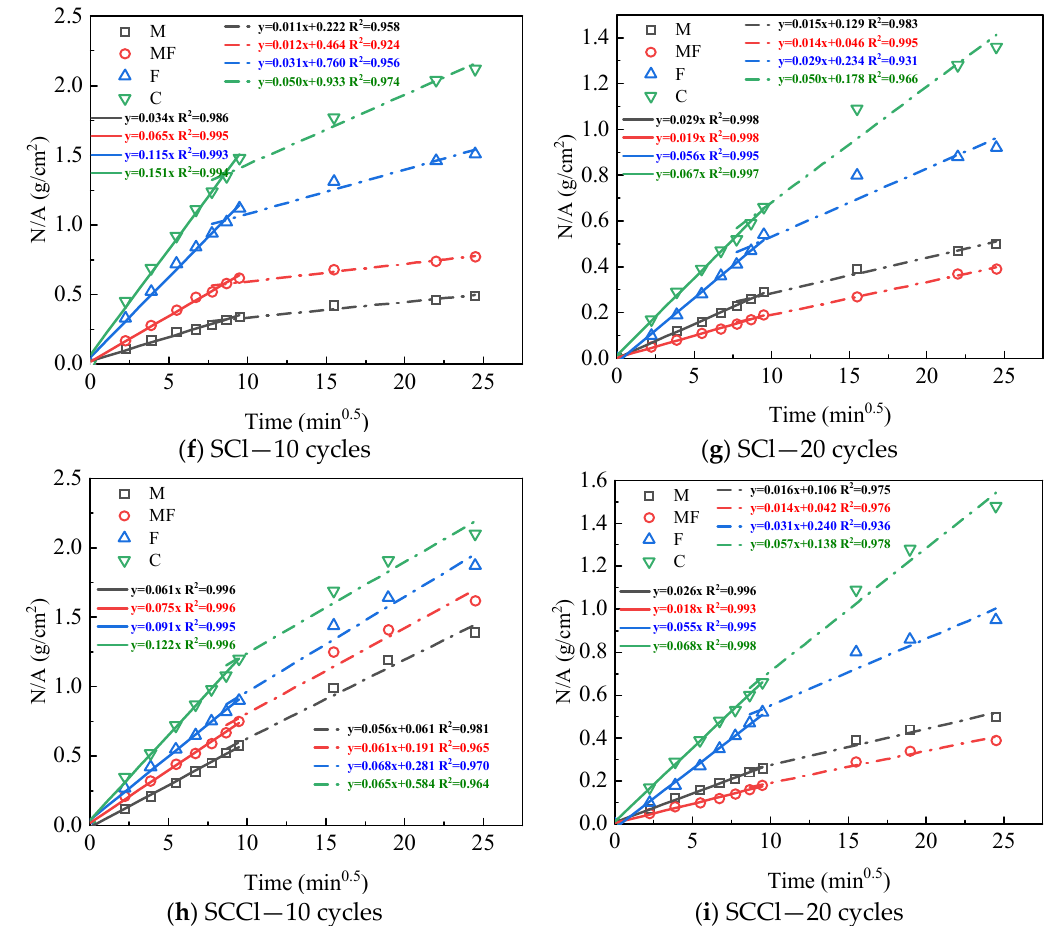
Figure 7. Capillary water absorption energy changes of mortar under different erosion environments. Table 3. Capillary water absorption coefficient (g/(cm 2 · min 0.5